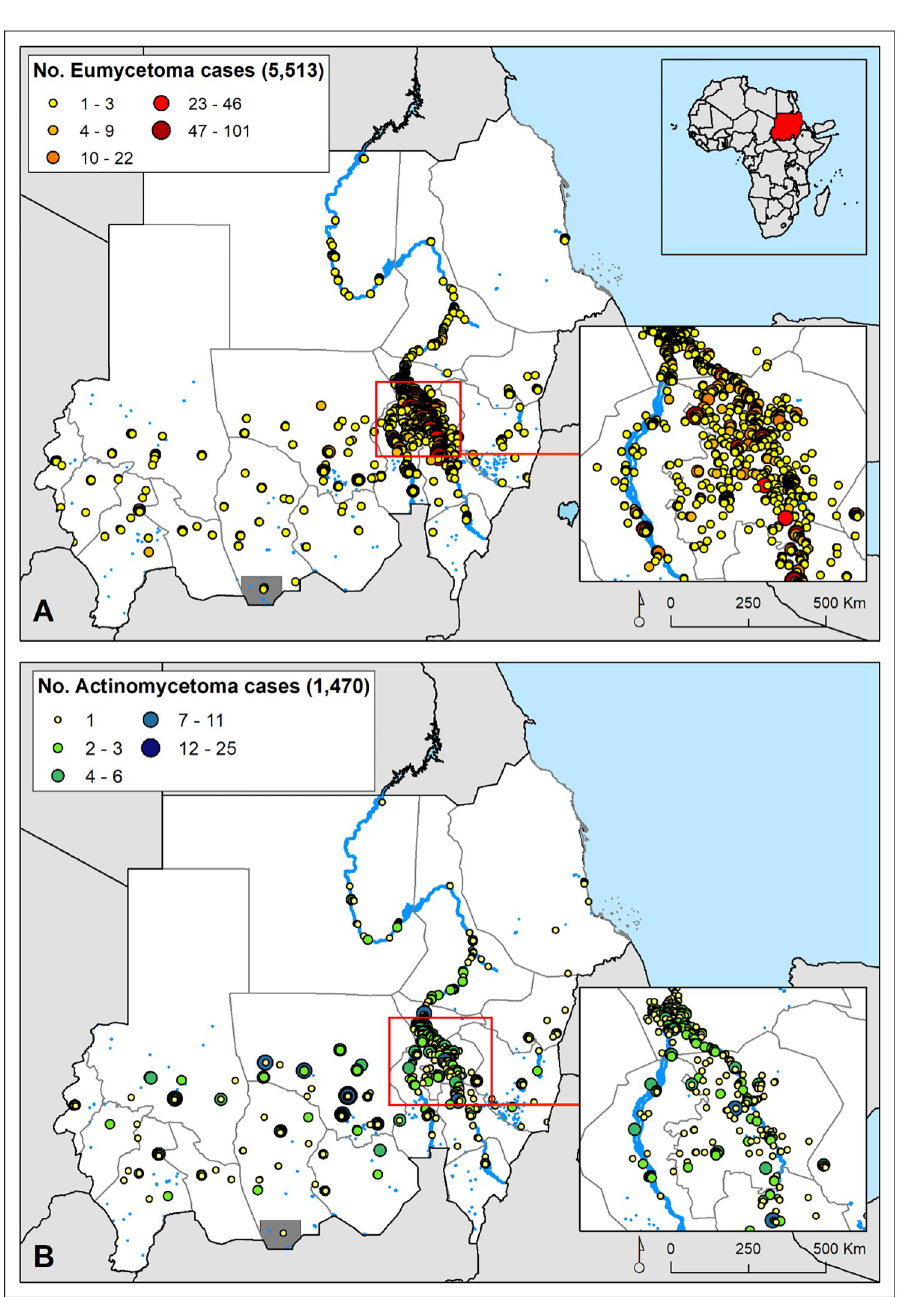
Fig 1. Distribution of eumycetoma (A) and actinomycetoma (B) cases recorded by the Mycetoma Research Centre from 1991 to 2018.